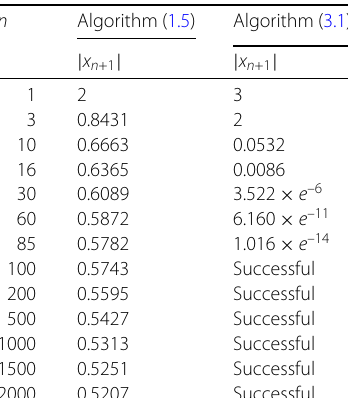
Table 2 Table of values choosing x 0 = –2, x 1 = 3 n Algorithm (1.5) Algorithm